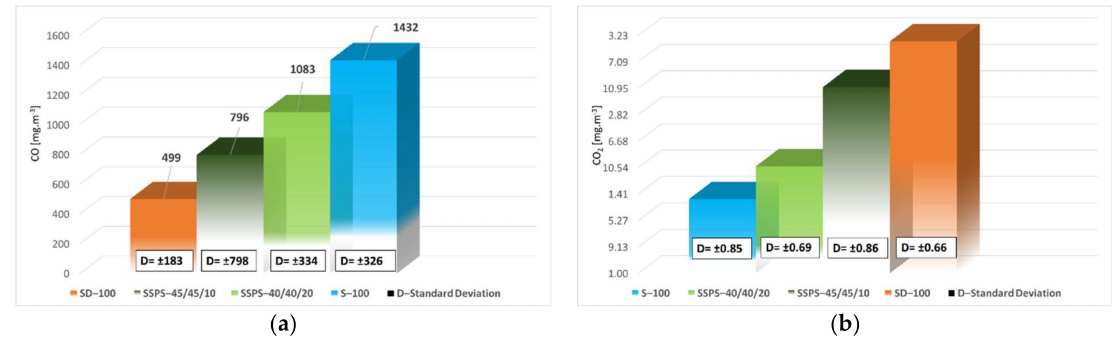
Figure 6. ( a ) Comparison of the average CO emissions, and ( b ) comparison of average CO 2